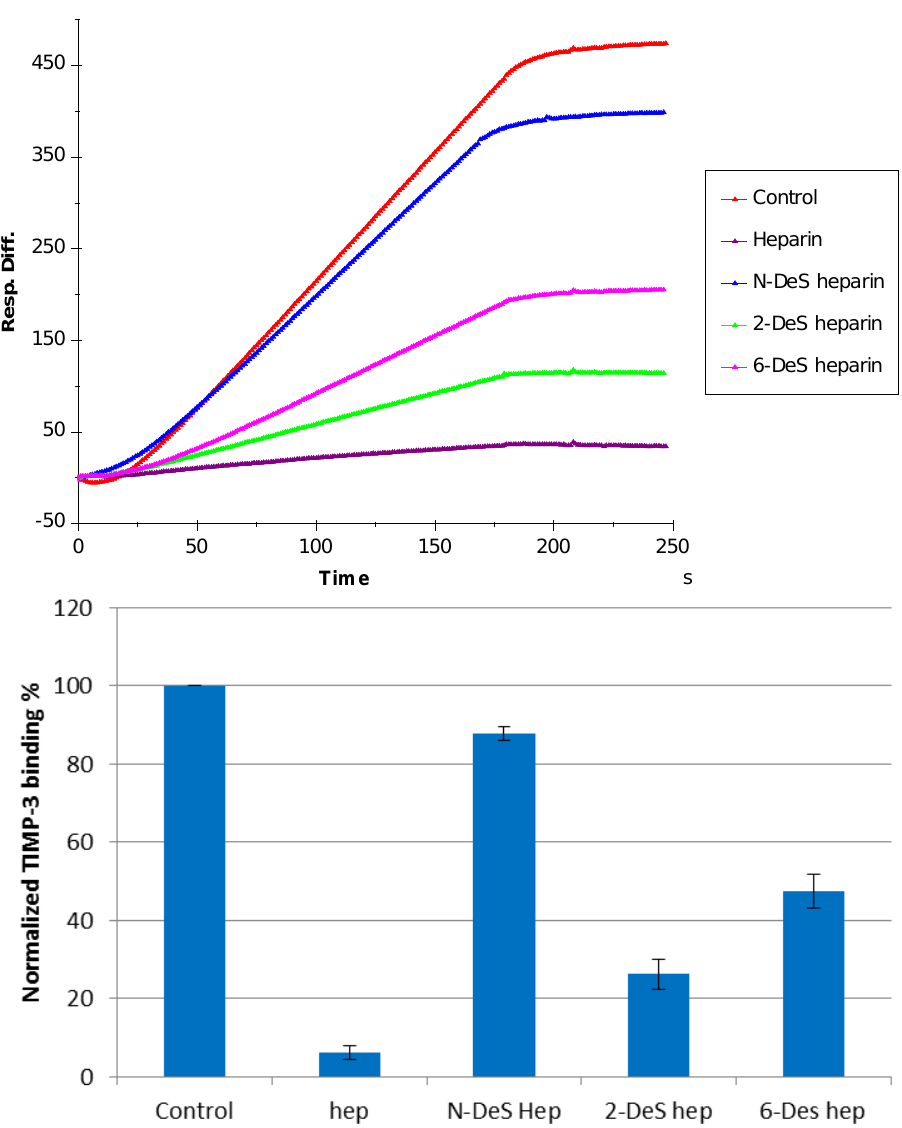
Figure 6. ( Top ): Sensorgrams of solution competition SPR using chemically modified heparin. TIMP-3 concentration was 10 nM, and concentrations of chemically modified heparin in solution were 1000 nM. ( Bottom ): Bar graphs (based on triplicate experiments with standard deviation) of normalized TIMP-3 binding preferences to surface heparin by competing with different chemically modified heparin in